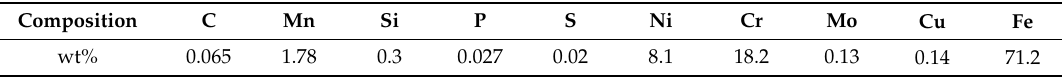
Table 1. Chemical composition of AISI 304 austenitic stainless steel.